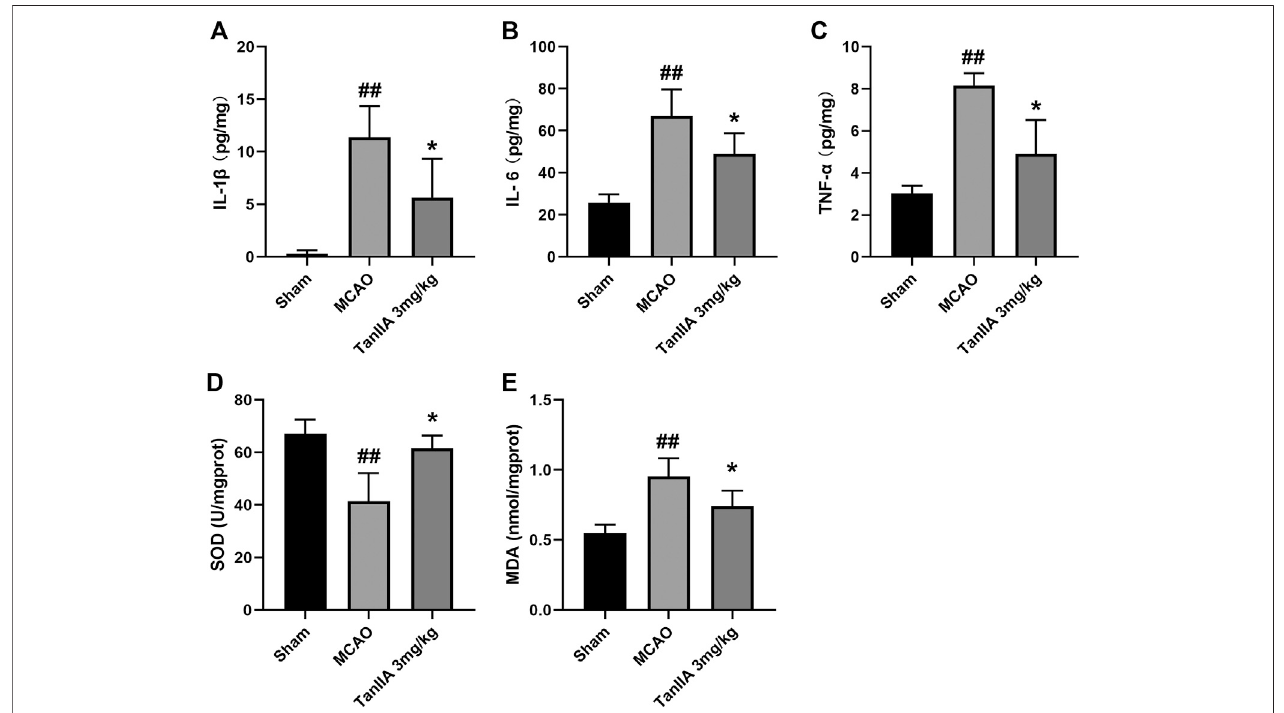
FIGURE 2 | Tanshinone IIA inhibited in fl ammatory cytokines and Oxidative Damage in MCAO rats. Tanshinone IIA or control saline was injected into the tail vein at theindicatedtimeafterMCAO.Afterreperfusion,theratbrainswereharvested.ELISAwasusedtodetectlevelsofIL-1 β (A) ,IL-6 (B) andTNF- α (C) .SODkitandMDAkit wereusedtodetectthelevelsofSOD (D) andMDA (E) .## p < 0.01,comparedwiththeShamgroup,* p < 0.05,comparedwiththeMCAOgroup.Sham,shamoperation group; MCAO, middle cerebral artery occlusion; TanIIA, Tanshinone IIA, n (cid:1) 3.